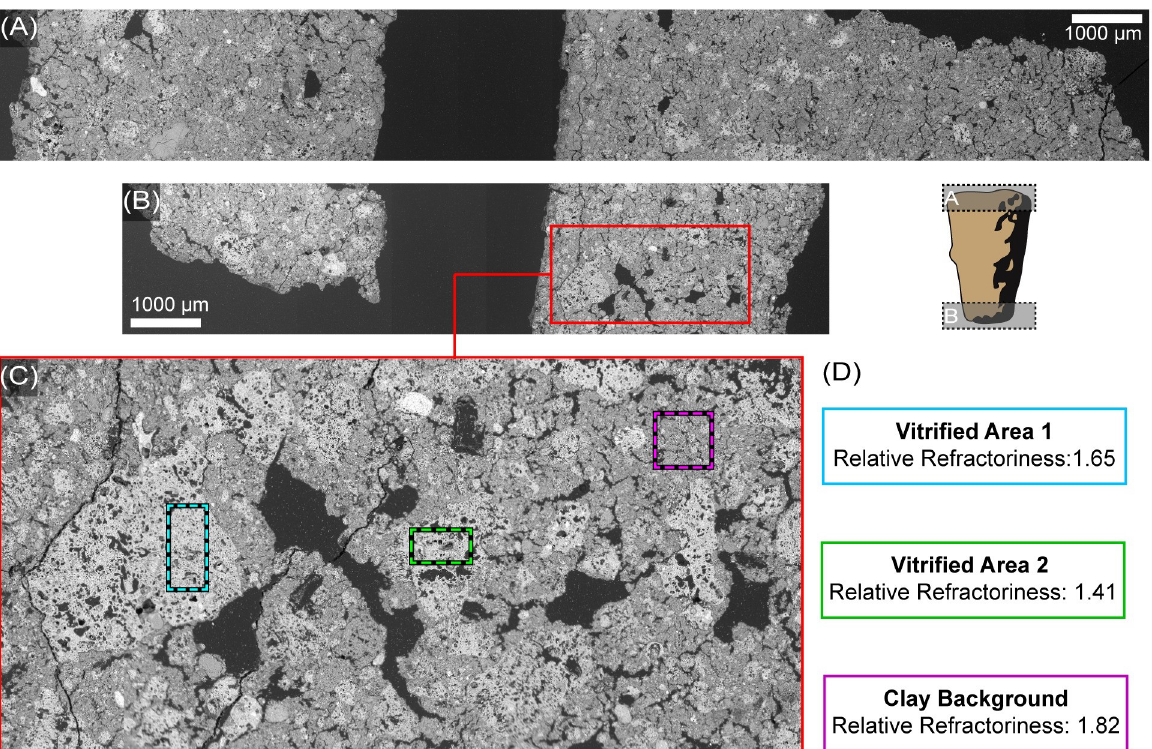
Fig 9. SEM-EDS Analysis of tuy è re M-16. (A) Composite backscattered electron (BSE) micrograph along the hypothesized proximal of the tuy è re showing frequent areas of increased vitrification, identified as brighter regions in the image. (B) Composite BSE micrograph along the hypothesized distal end of the tuy è re, which exhibits more vitrification than the proximal end. (C) Higher magnification micrograph allows comparison of more vitrified regions (blue and green boxes) to the clay background (magenta box). (D) The relative refractoriness of each region in (C) calculated using quantified EDS data. Images by Jennifer Meanwell and Linda